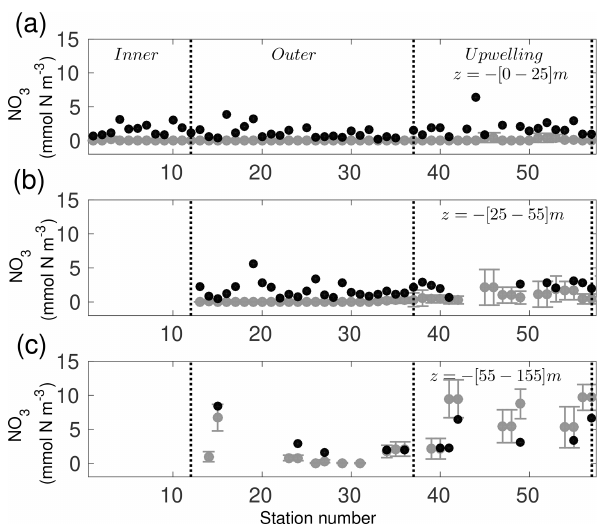
Figure 7. Same as Fig. 4, but for nitrate concentrations (mmolNm − 3 ).